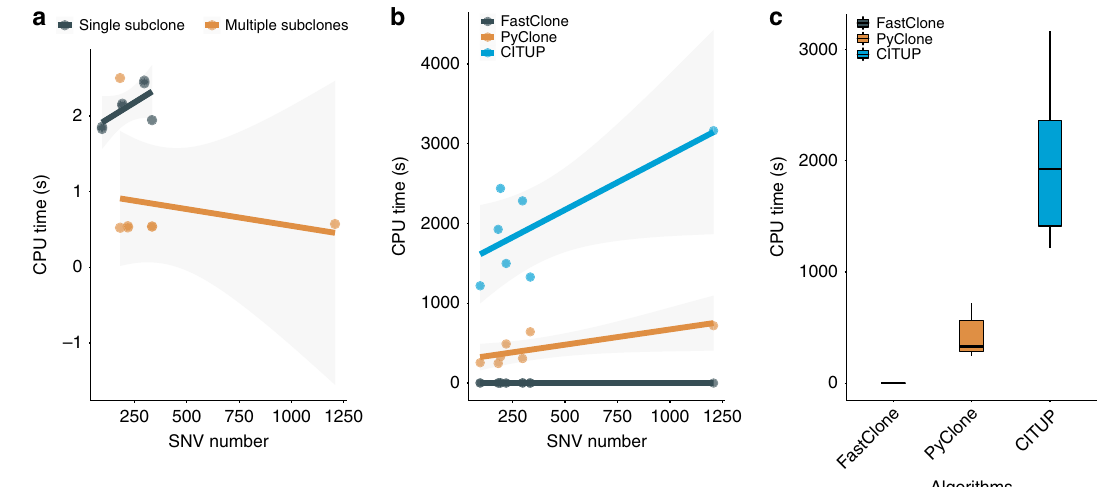
Fig. 5 Computation time of FastClone, PyClone, and CITUP. a Running FastClone on the patient data. The SNV number barely affects computation time in real-world data since FastClone removes noise from data fi rst. b Running FastClone, PyClone, and CITUP on the patient data. Each dot at the right-bottom section represents a primary tumor sample. In general, computation time increases as the sample involves more mutations. c Comparing FastClone to PyClone and CITUP based on their computation time. In the box plot, center lines refer to median CPU time, bounds of box refer to the fi rst quartile and the third quartile of the data, and whiskers refer to min and max of the